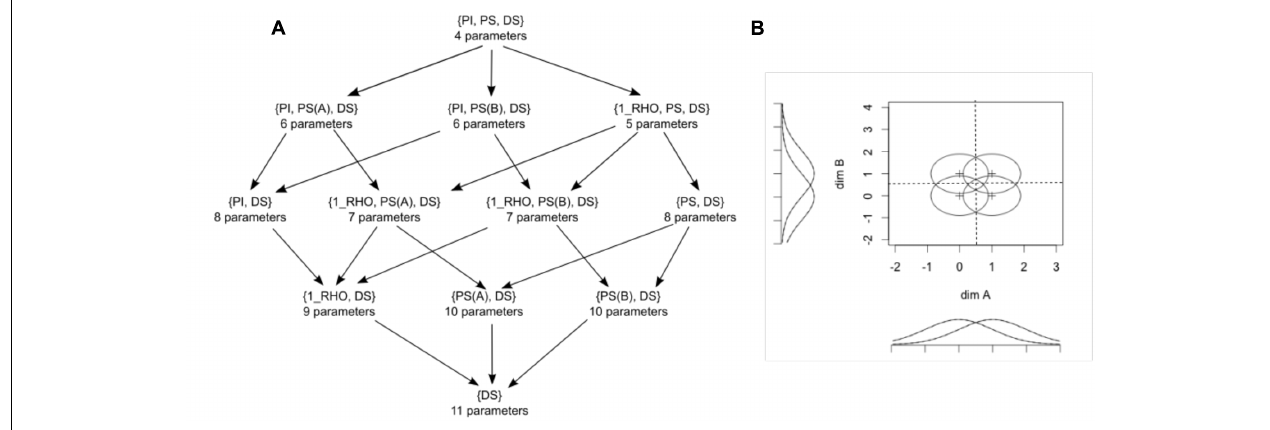
FIGURE 6 | (A) Hierarchy of models used in a model-based analysis of data from a 2 × 2 identification task using traditional general recognition theory with grtools. PI stands for perceptual independence, PS for perceptual separability, DS for decisional separability, and 1_RHO for a single correlation in all distributions. The number of free parameters in each model is indicated below its label. (B) Initial configuration assuming PS, PI, and DS.